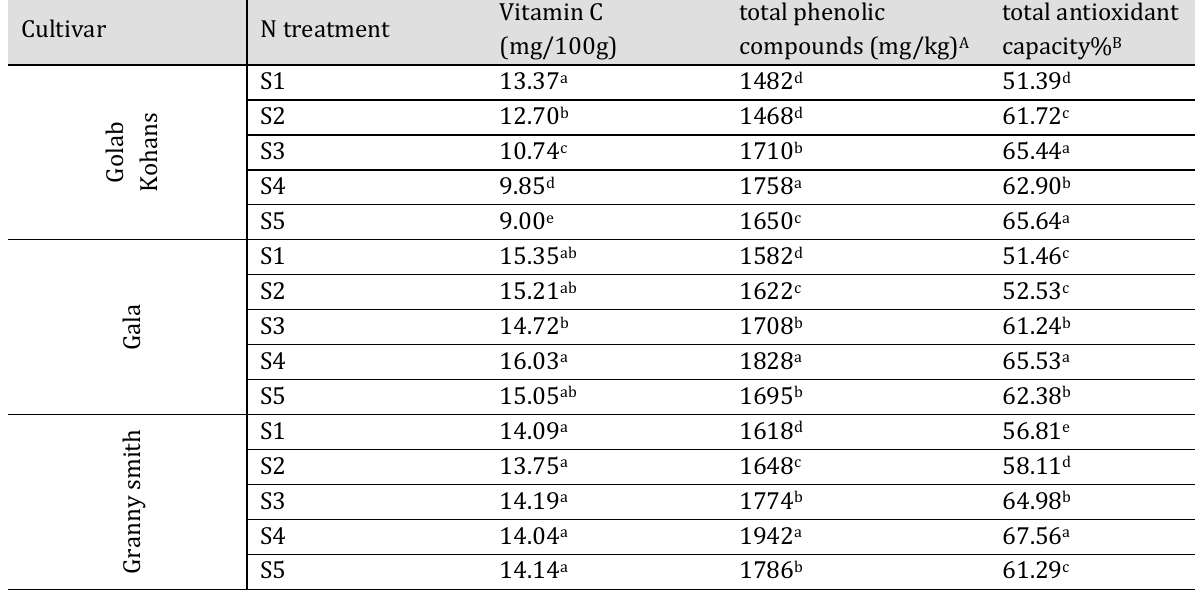
Table 1. The effect of various levels of ammonium to total nitrogen in nutrition solutions on vitamin C content (mg/100g) , total phenolic compounds (mg/kg), and total antioxidant capacity (%) of three apple cultivars (‘Golab Kohans’, ‘Gala’ and ‘Granny Smith’).